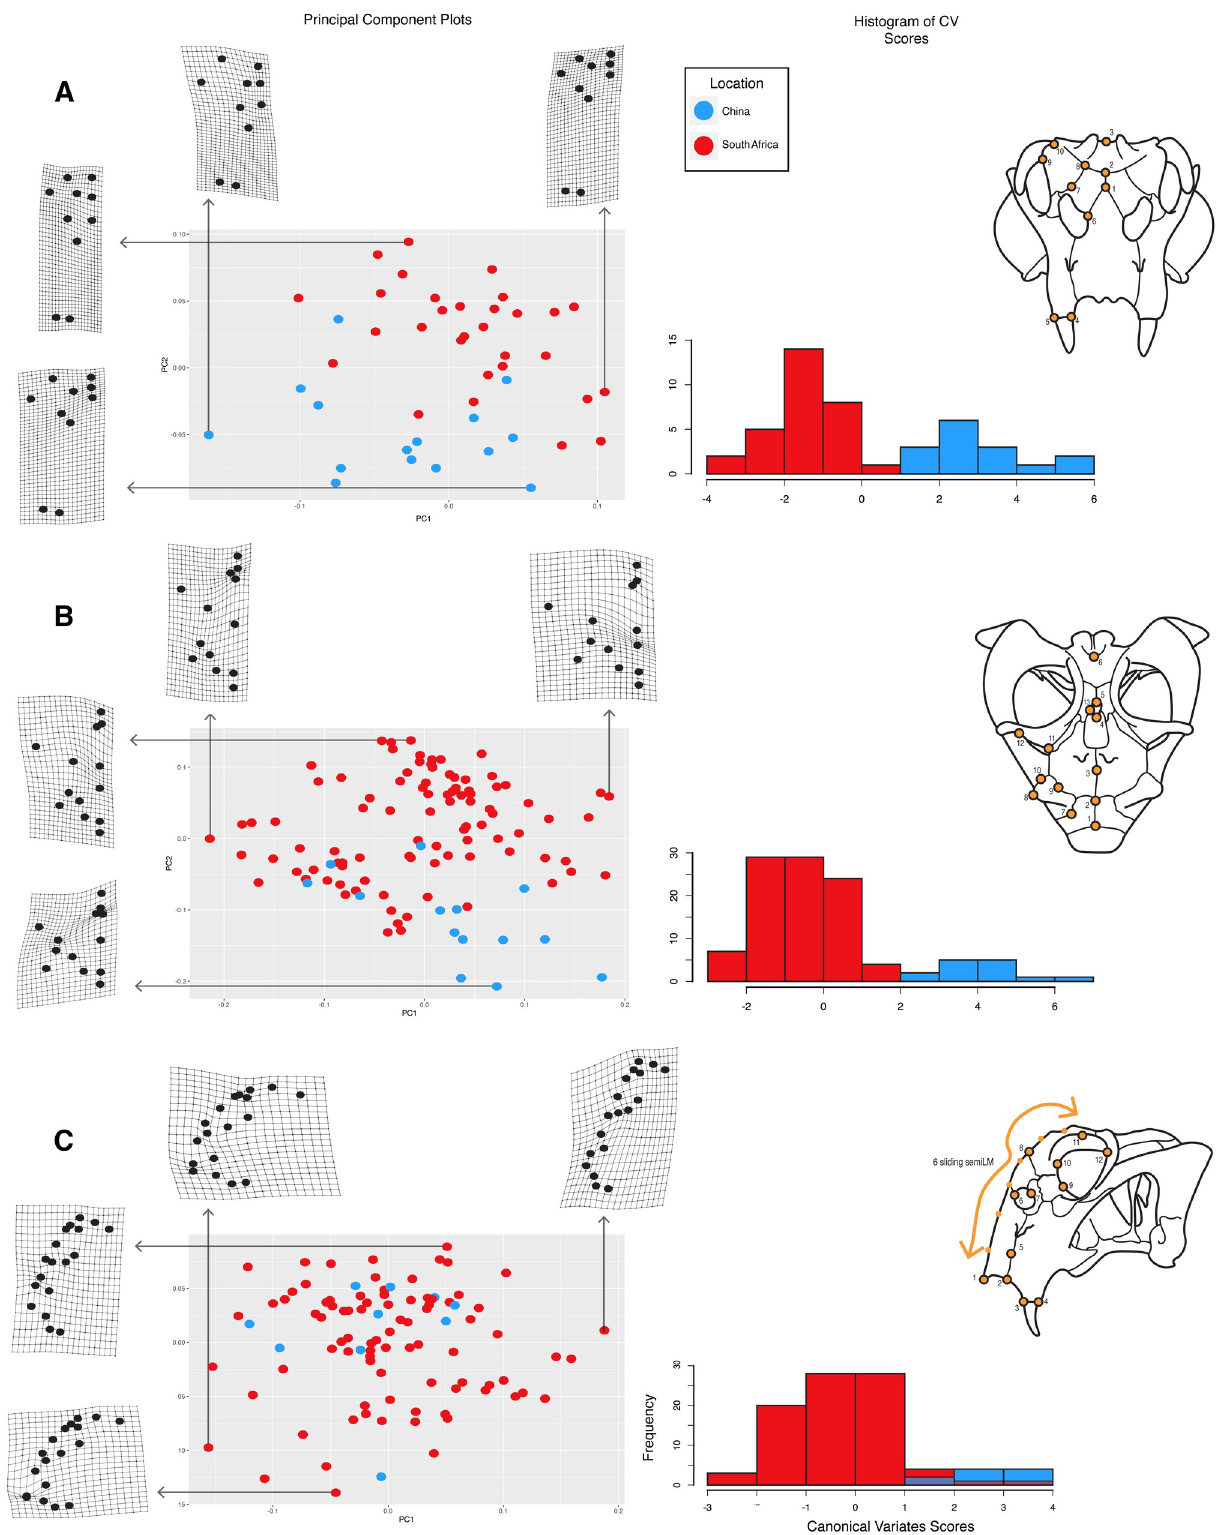
Fig 2. Results of the morphometric analysis comparing specimens of Lystrosaurus from China and South Africa. Principal components plots and histograms of canonical variates analysis results for the three perspectives (Anterior–A; Dorsal–B; Lateral–C). Skull drawings on the right correspond to